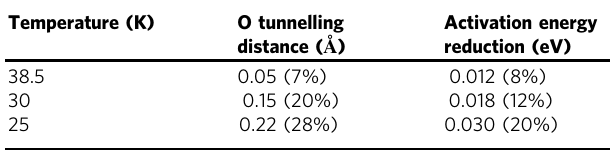
Table 3 Characteristic quantities of tunnelling calculated from the instantons at different